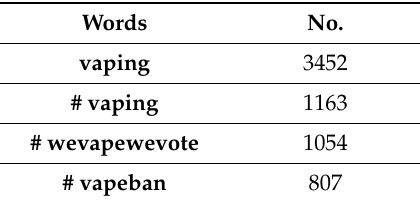
Table 3. Most frequently occurring words in Group 2.